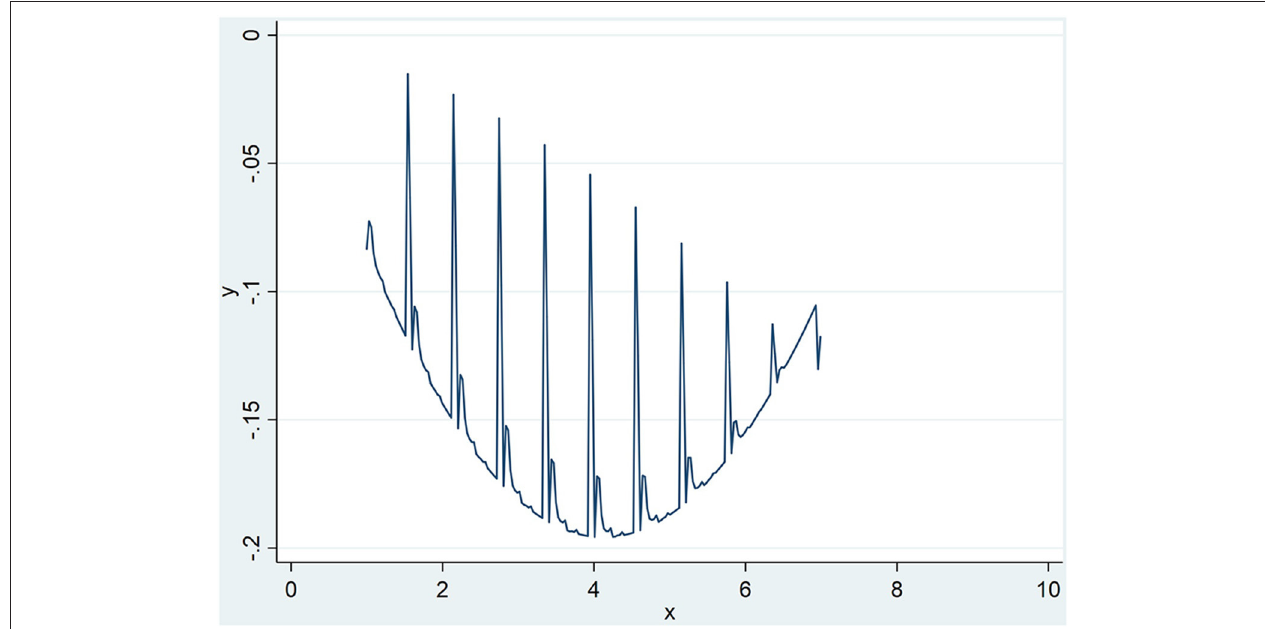
FIGURE 1 | U-shape curve change under different level of